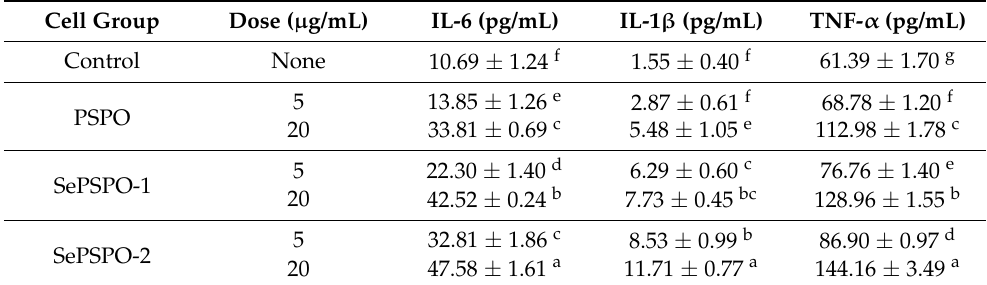
Table 1. The measured cytokine levels in the macrophages incubated with PSPO, SePSPO-1, and SePSPO-2 for 24 h. Cell Group Dose ( µ g/mL) IL-6 (pg/mL) IL-1 β (pg/mL) TNF- α (pg/mL) None